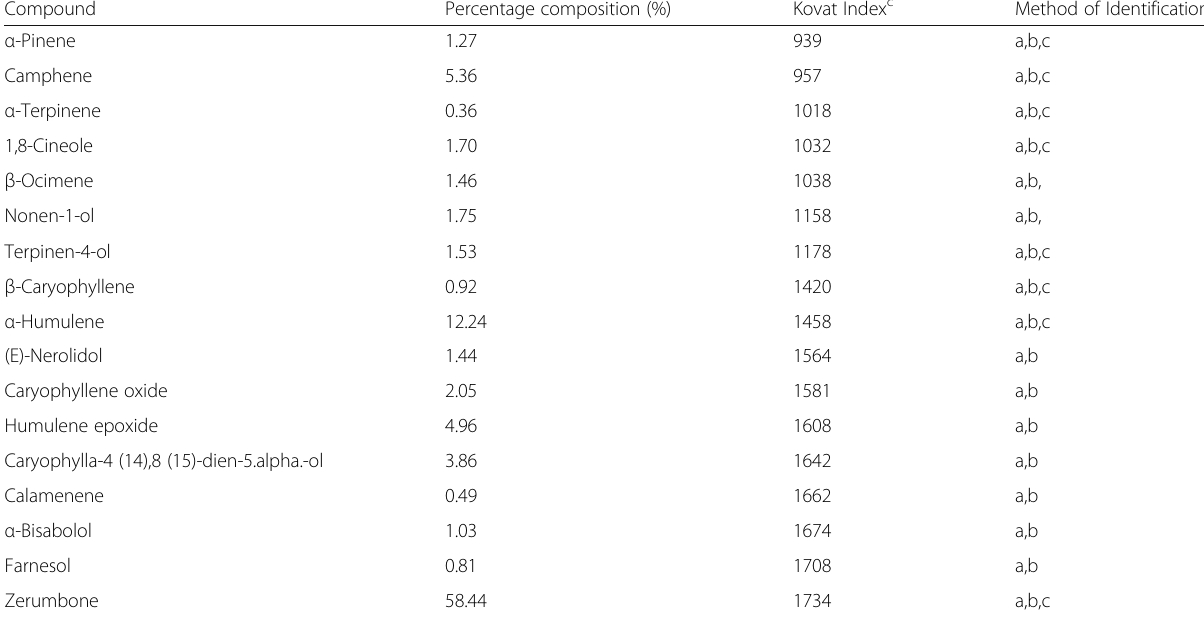
Table 1 Percentage composition of essential oil of Zingiber zerumbet Compound Percentage composition